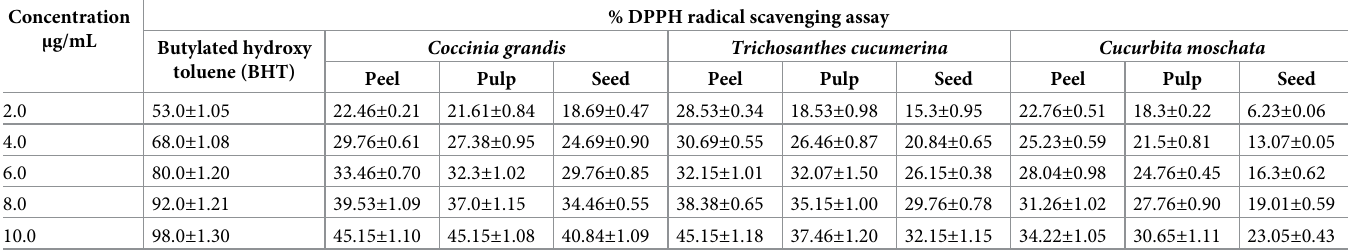
Table 4. The antioxidant activity of the aqueous extracts of various parts of studied Cucurbitaceae vegetables evaluated by the DPPH radical scavenging assay. Concentration μ